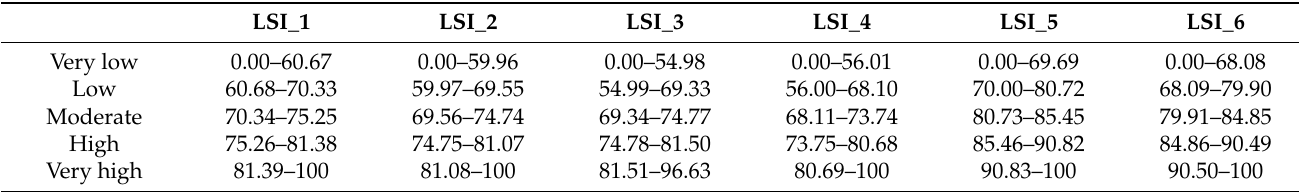
Table A7. Thresholds between the susceptibility classes for the models created with the LSI